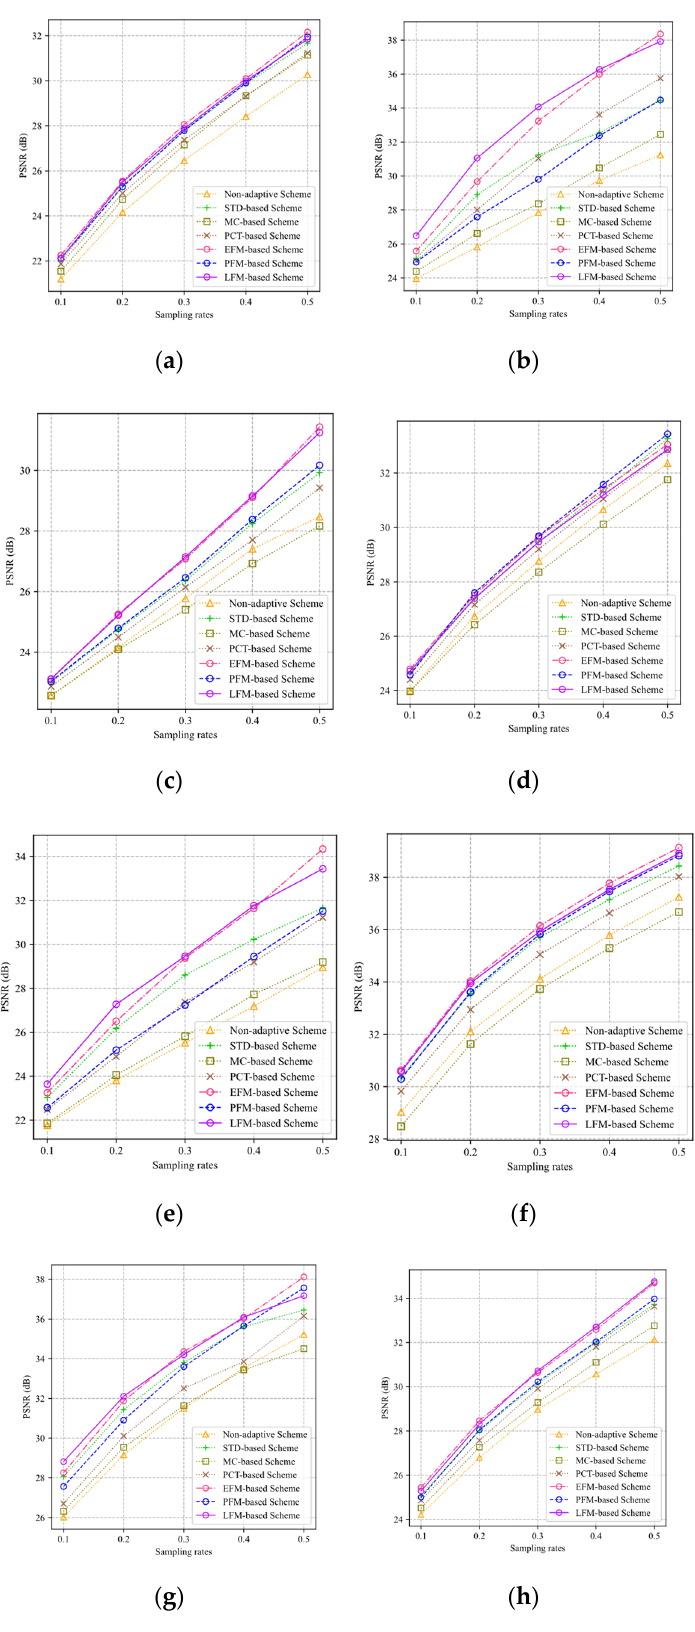
Figure 14. PSNR curves of eight test images: ( a ) Monarch; ( b ) Parrot; ( c ) Barbara; ( d ) Boats; ( e ) Cam- eraman; ( f ) Foreman; ( g ) House; ( h ) Lena.